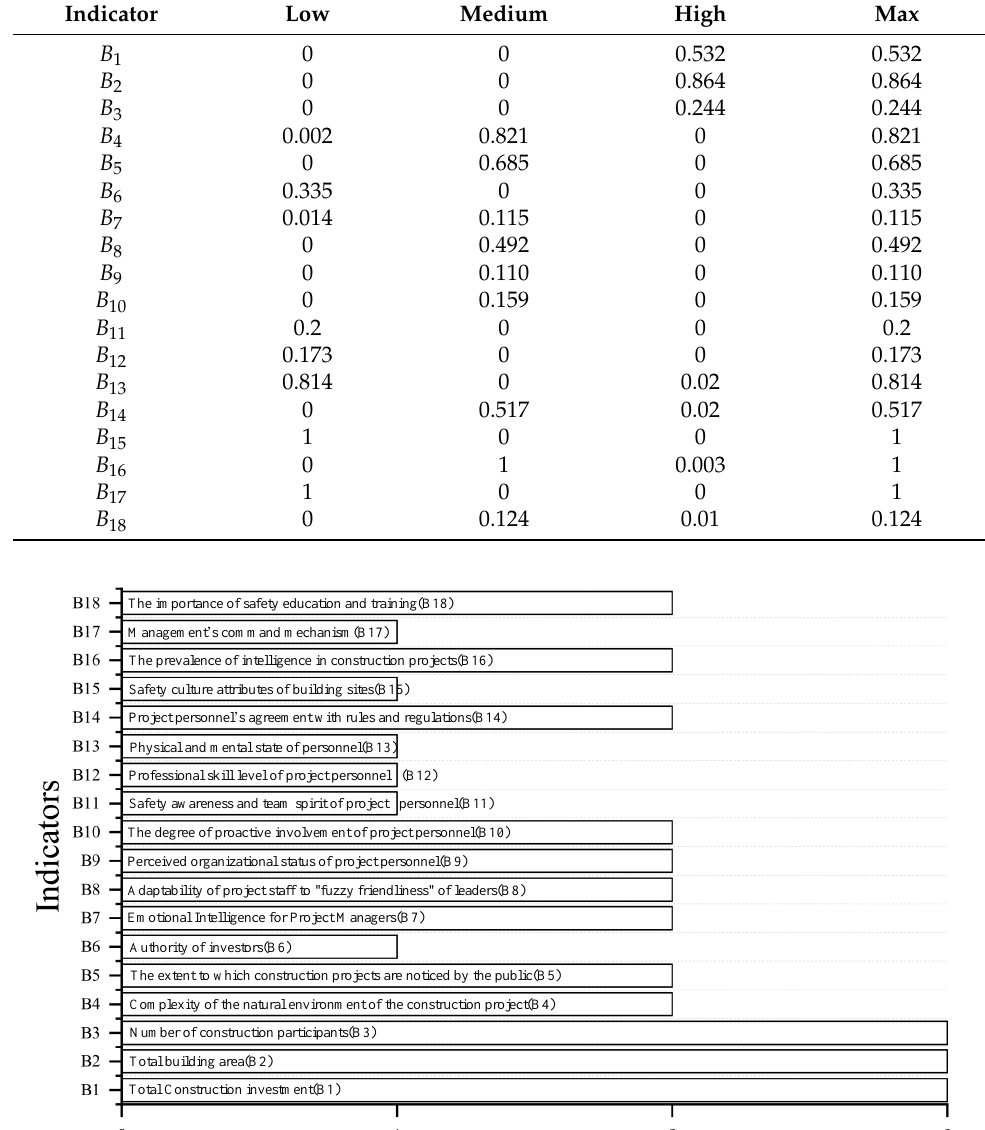
Table 9. Comprehensive correlation.